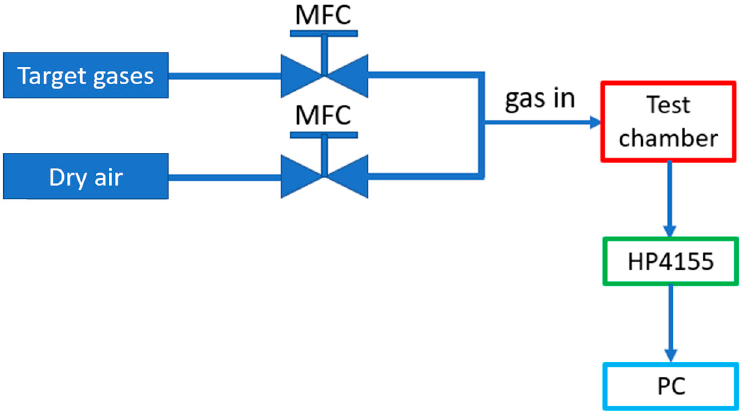
Figure 4. Gas sensor measurement setup.